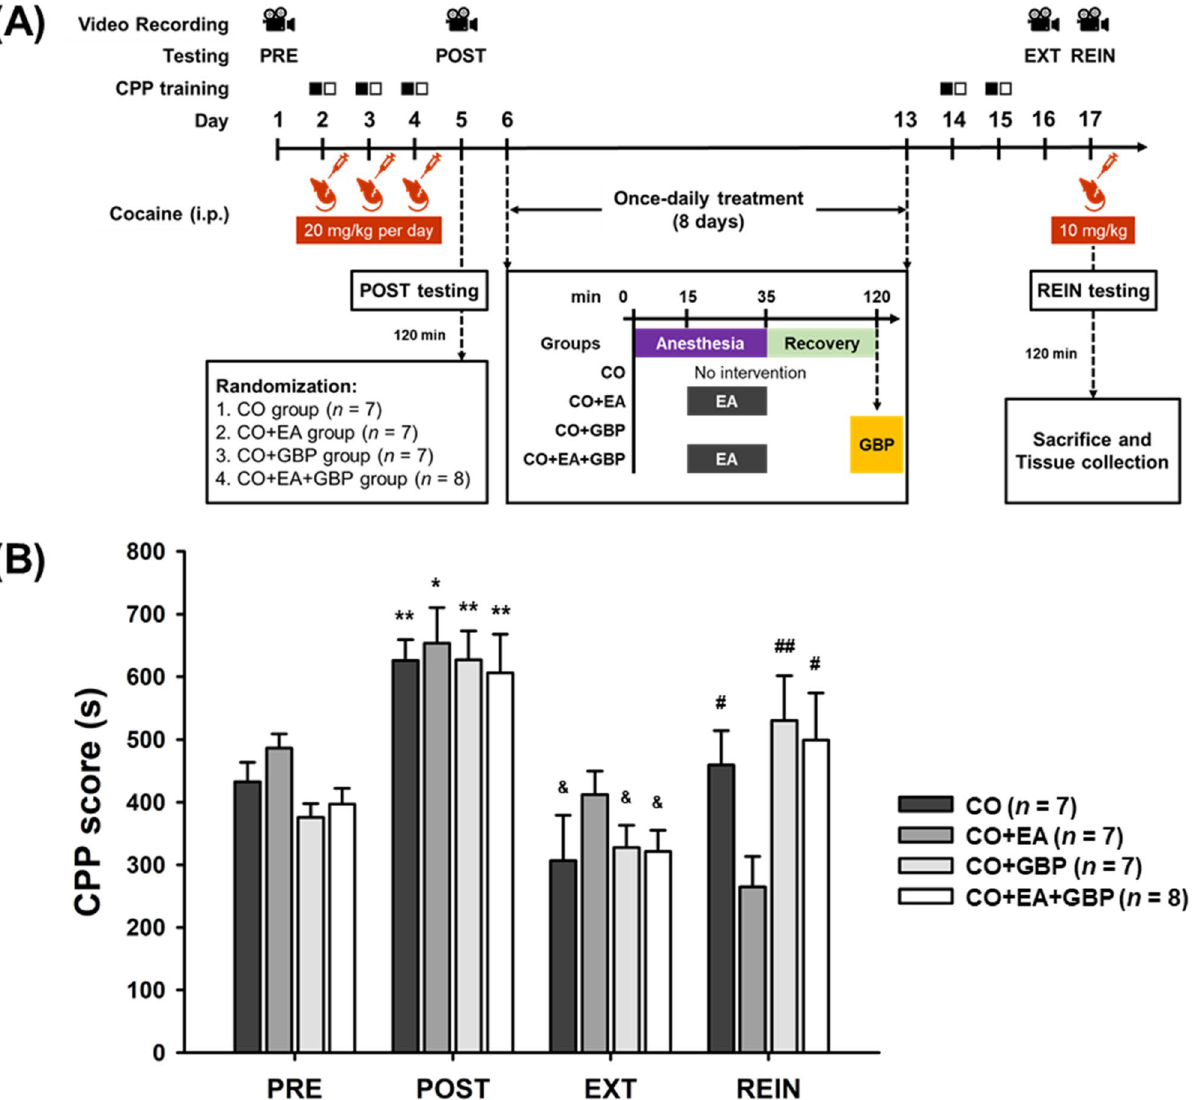
Figure 2. GBP significantly reversed the effects of EA on cocaine-induced relapse behavior. ( A ) Timeline of CPP testing, training, cocaine administration, and experimental interventions. ( B ) CPP scores for the CO group, CO + EA group, CO + GBP group and CO + EA + GBP group, obtained during PRE, POST, EXT, and REIN testing. * p < 0.05; ** p < 0.01 versus the PRE phases; & p < 0.05 versus the REIN phases; # p < 0.05; ## p < 0.01 versus the CO + EA group in REIN phases (two-way ANOVA with the LSD post-hoc test). All data are expressed as the means ± S.E.M. ( n = 7–8 mice per group). Abbreviations: CPP = Cocaine-induced conditioned place preference; PRE = Preconditioning testing; POST = Post-conditioning testing; EXT = Extinction of cocaine CPP testing; REIN = Cocaine-primed reinstatement testing; CO = No intervention; CO + EA = EA treatment; CO + GBP = i.p. GBP (1 mg/kg) injection; CO + EA + GBP = EA treatment followed by i.p. GBP (1 mg/kg) were significantly lower in the CO + EA group compared with those in the CO group ( p < 0.05), the CO + GBP group ( p < 0.01) and the CO + EA + GBP group ( p < 0.05). Factor analysis revealed significant between-phase differences in all groups (CO group: F [1.443, 8.656] = 8.085 with Greenhouse–Geisser correction for sphericity, p < 0.05; CO + EA group: F [3,18]= 14.674, p < 0.001; CO + GBP group: F [3,18] = 11.637, p < 0.001; CO + EA + GBP group: F [3,21] = 5.785, p < 0.01). Post-hoc analysis revealed significant increases in CPP scores in the POST phase compared with the PRE phase (CO group: p < 0.01; CO + EA group: p < 0.05; CO + GBP group: p < 0.01; CO + EA + GBP group: p < 0.01) and the EXT phase (CO group: p < 0.05; CO + EA group: p < 0.01; CO + GBP group: p < 0.01; CO + EA + GBP group: p < 0.01) for all groups. Moreover, CPP scores were significantly higher in the REIN phase compared with the EXT phase in the CO group, the CO + GBP group, and the CO + EA + GBP group (all p < 0.05), but not the CO + EA group. Thus, while EA at LI4 and LI11 significantly reduced the CPP score, adding GBP to EA significantly reversed the effects of EA (Fig. 2B and Supplementary Fig. S2).